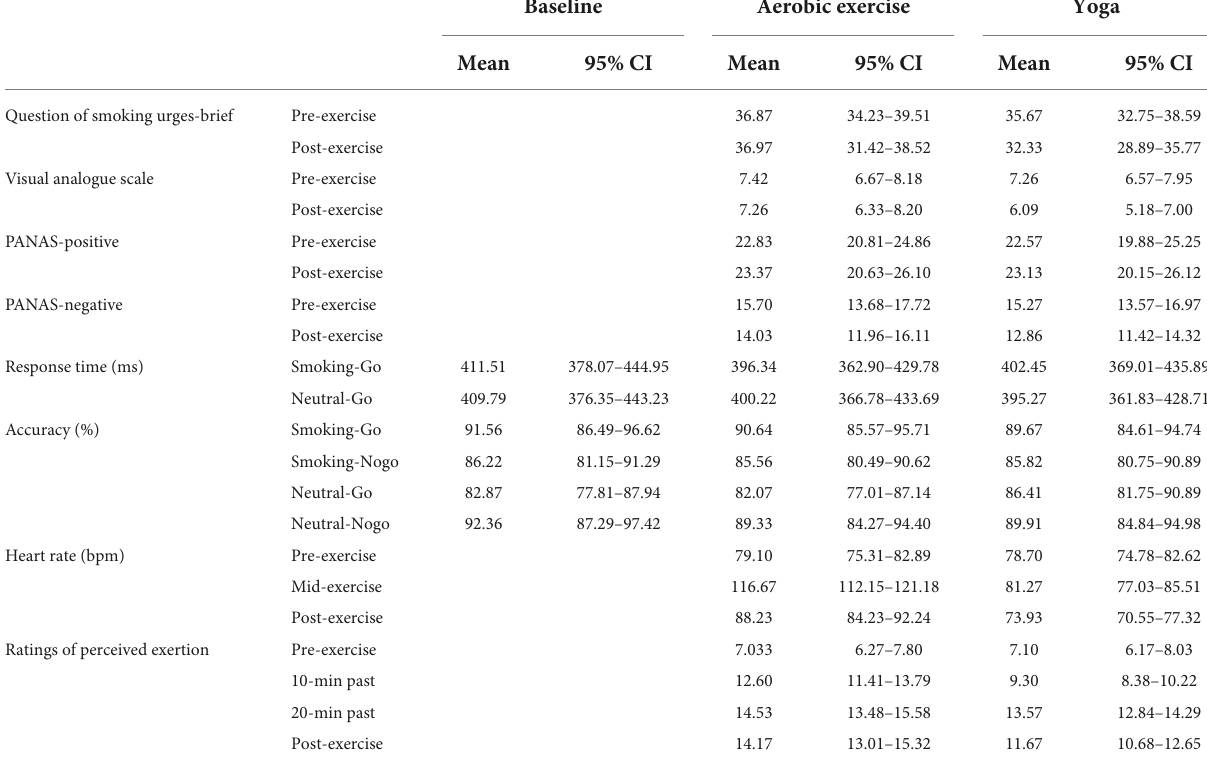
TABLE 1 Differences in craving, affect, cognitive performance, and exercise